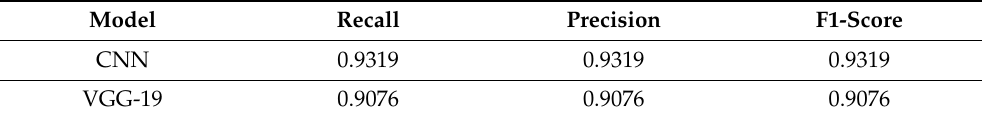
Table 6. Recall, precision and F1-score values of models used for pavement crack classification. Model Recall Precision F1-Score